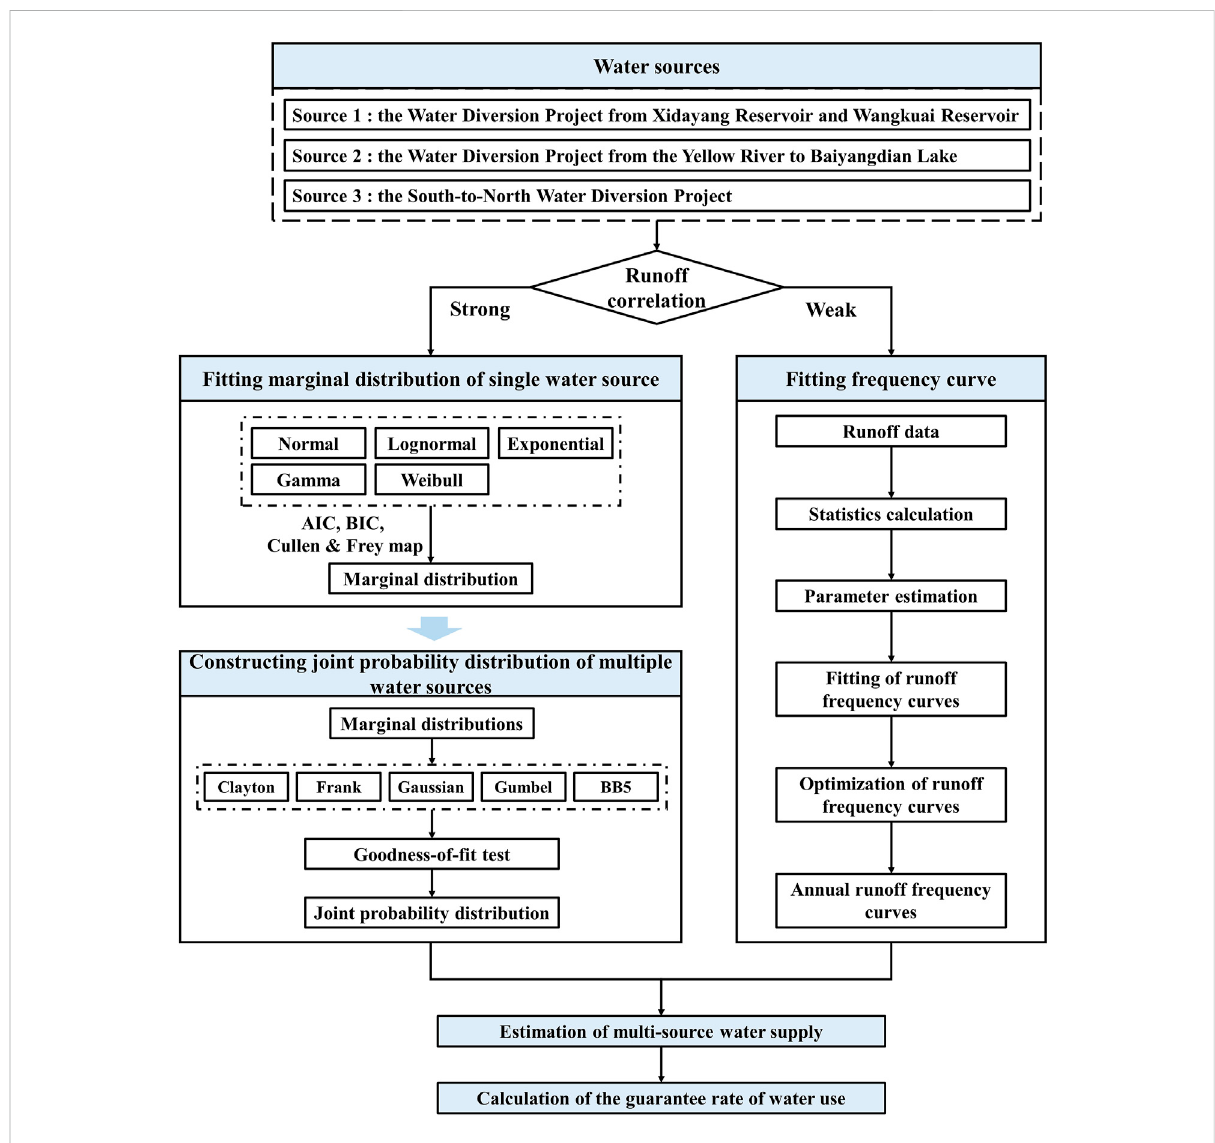
FIGURE 2 Framework for estimating the water supply for multiple water